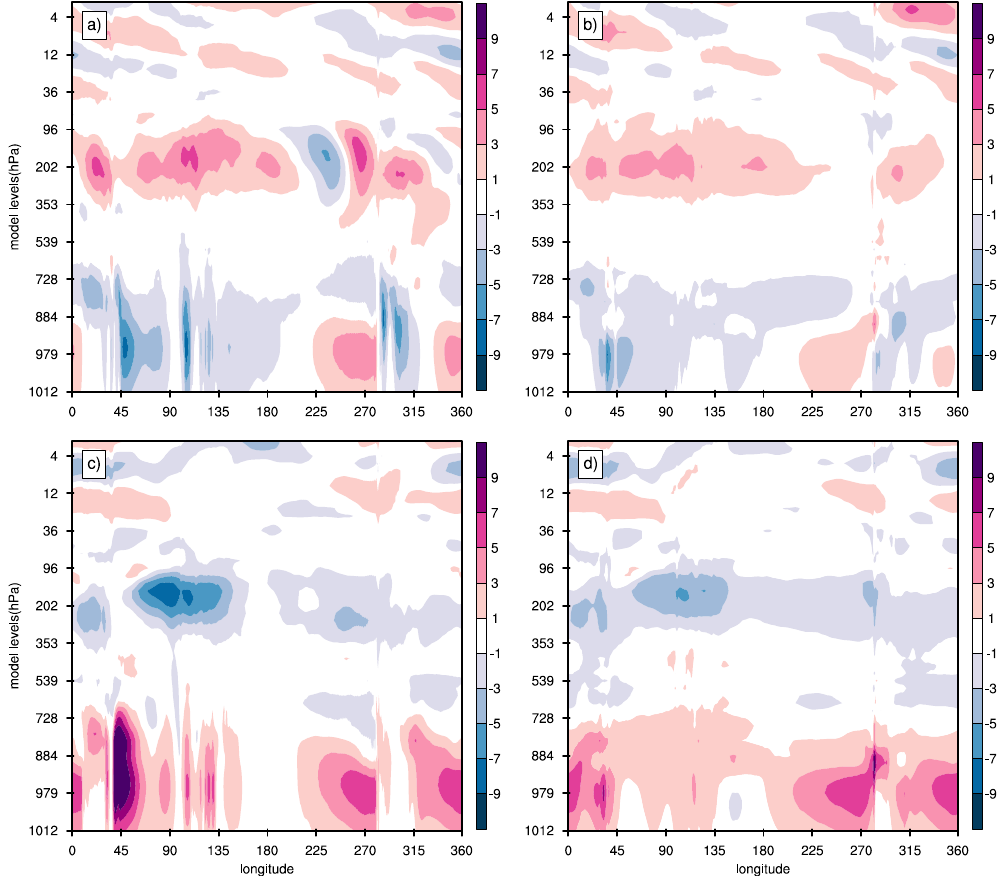
Figure 11. Meridional winds along the Equator in (a, b) January and (c, d) July. (a, c) All modes and (b, d) unbalanced modes. Spacing is every 2ms − 1 with positive values (northerly wind) in shades of magenta and negative values (southerly wind) in the blue shades. Wind are averaged in the belt between 5 degrees off the Equator (14 Gaussian grid points).